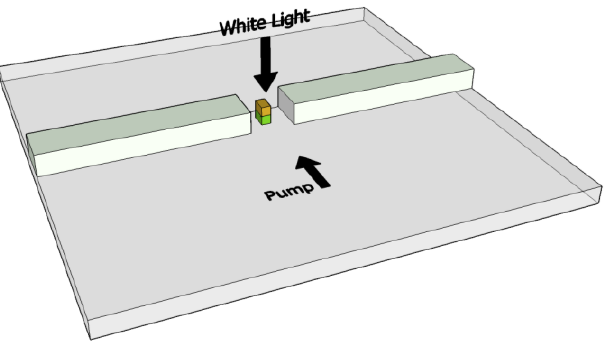
Figure 5. All-optical modulator based on plasmon resonance